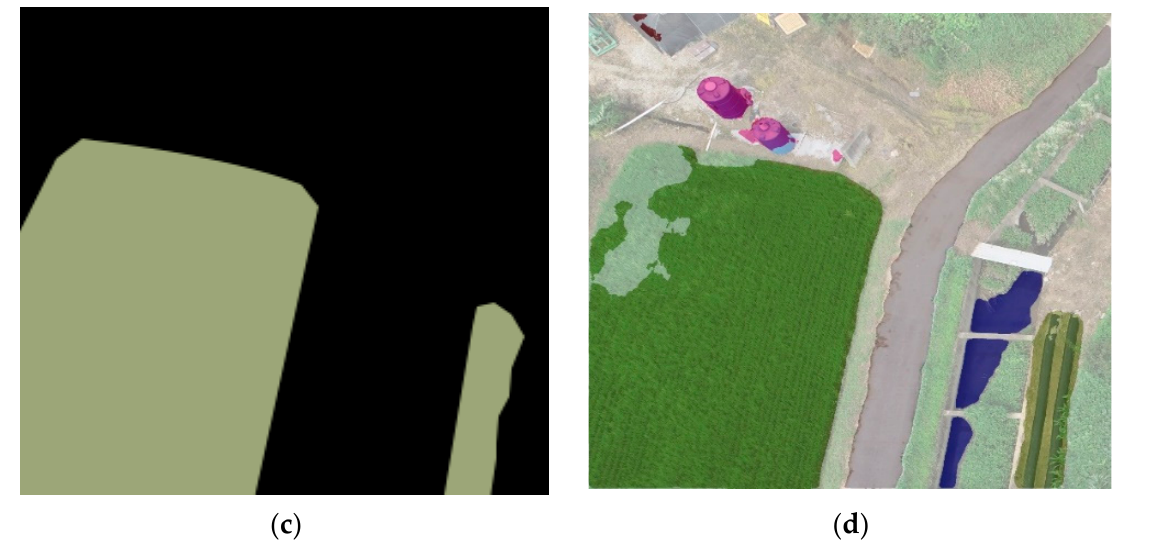
Figure 11. Training results: ( a ) ground truth of YOLOv5; ( b ) prediction of YOLOv5; ( c ) ground truth of DeepLabv3+; ( d ) prediction of DeepLabv3+.